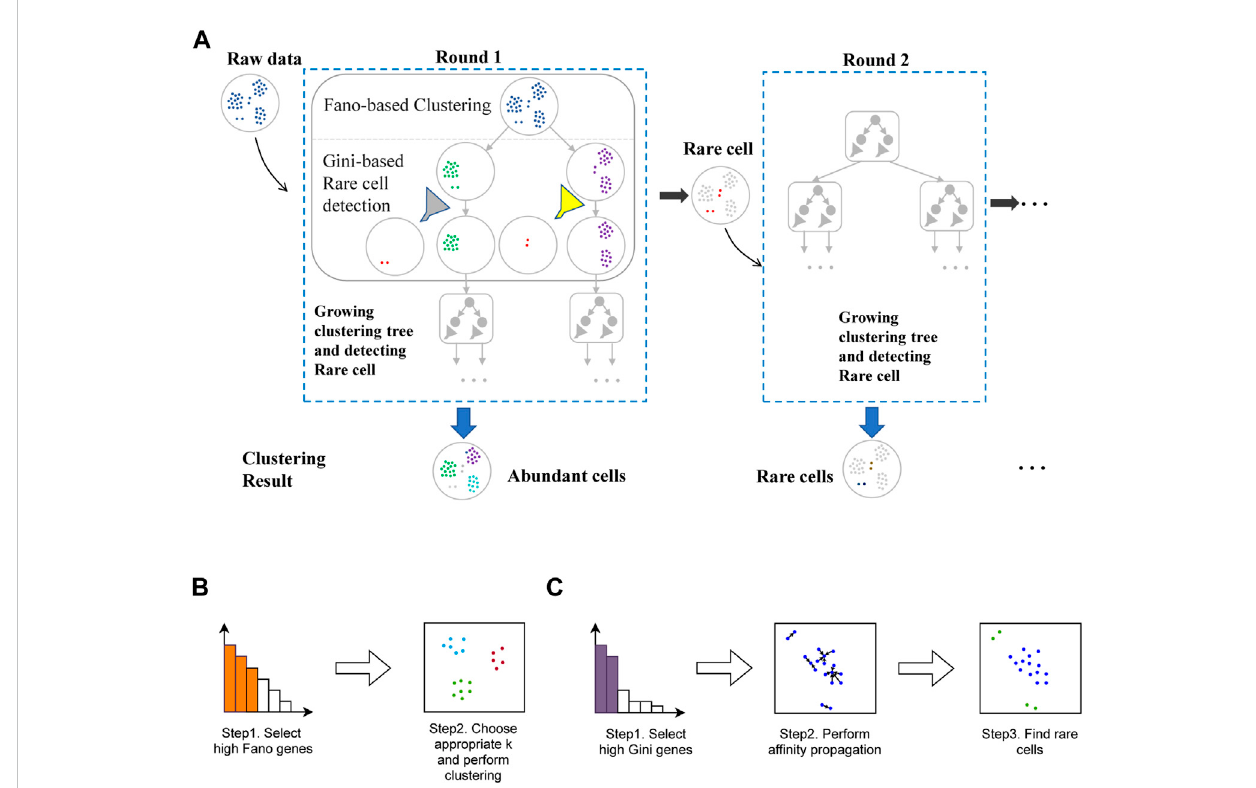
FIGURE 2 Overview ofProgClust. (A) The framework ofProgClust. ScRNA-seq data is input into the fi rst clustering tree.After Fano-based Clustering and Gini- based rare cell detection, the detected rare cells and common cells clustering results are obtained. The rare cells are input to the next clustering tree; (B) Fano-based clustering; (C) Gini-based Rare cell